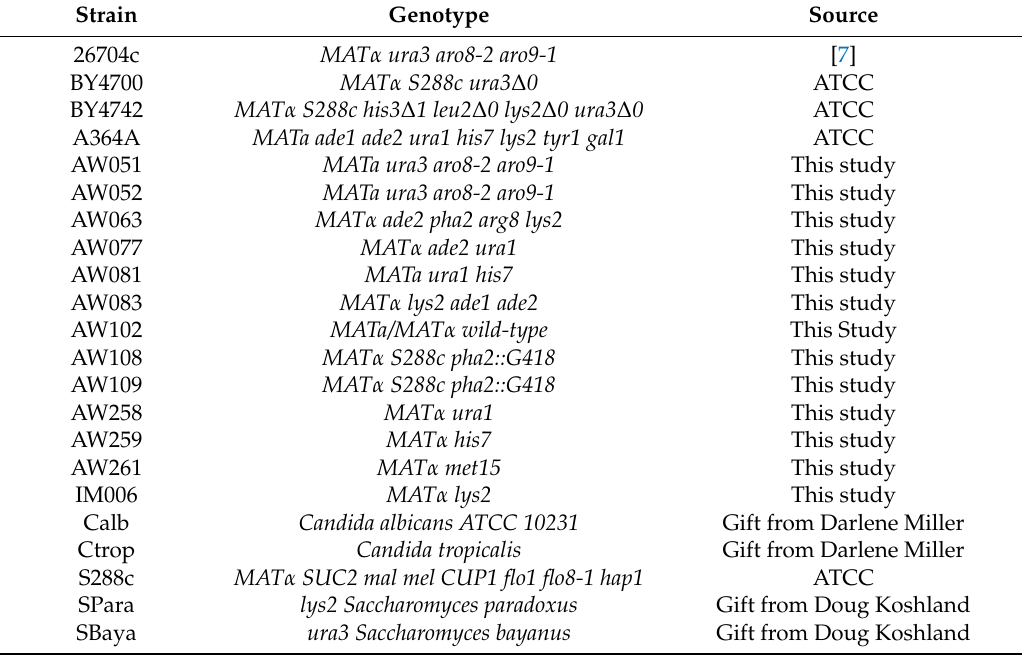
Table 2. List of yeast strains